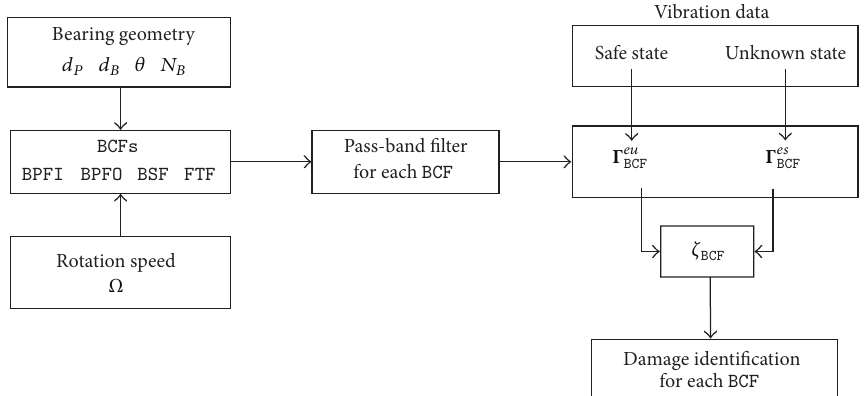
Figure 2: Flowchart of the subspace-based damage identification strategy.